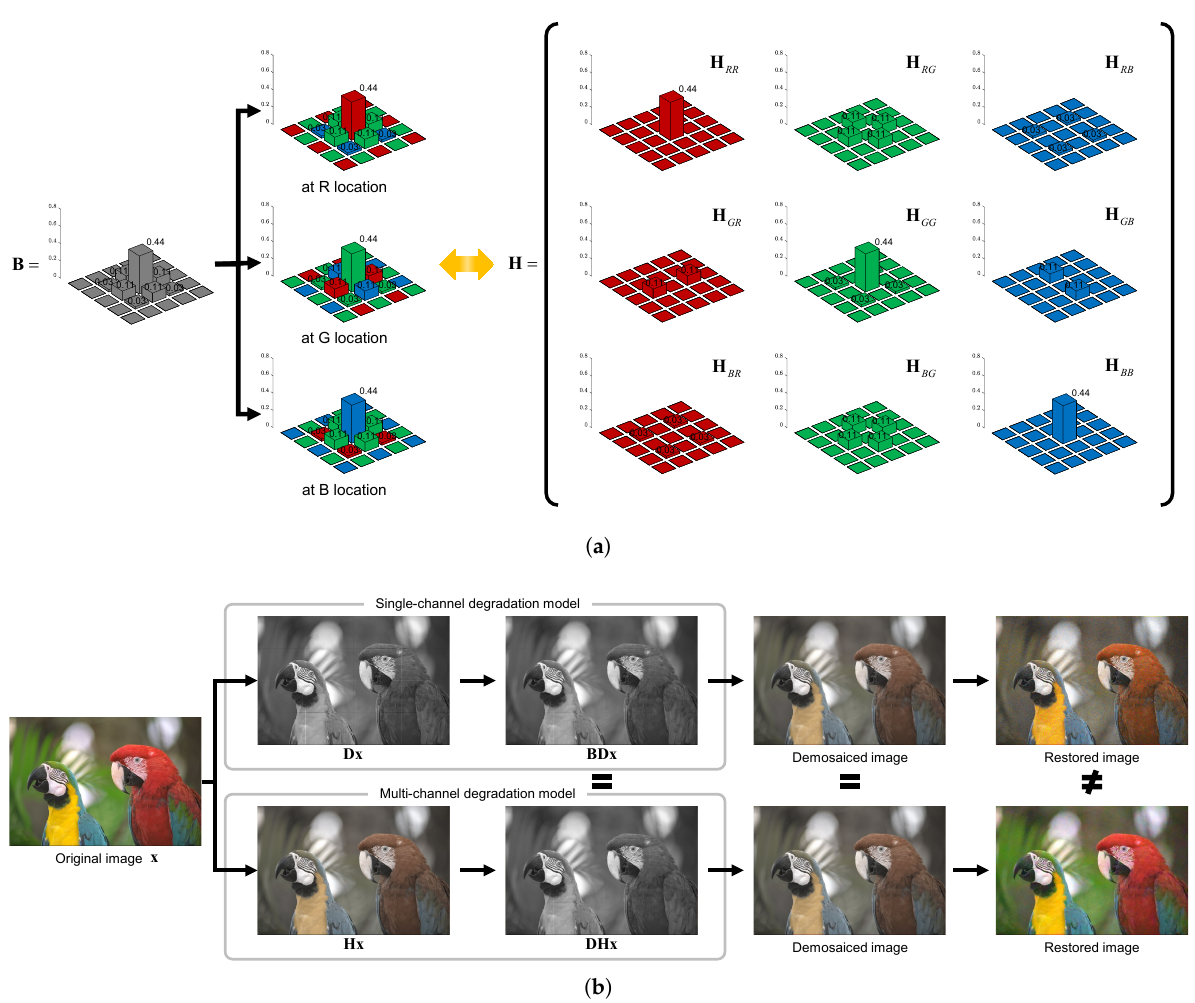
Figure 4. Example illustrations of single-channel and multi-channel degradation models: ( a ) Rela- tionship of B in the single-channel degradation model (left) and H in the multi-channel degradation model (right). ( b ) Comparison of the single-channel degradation model (top) and the multi-channel degradation model (bottom). ARI demosaicing is applied equally to degraded images. The same degraded results are produced by different formulations of the crosstalk phenomenon, but different results are